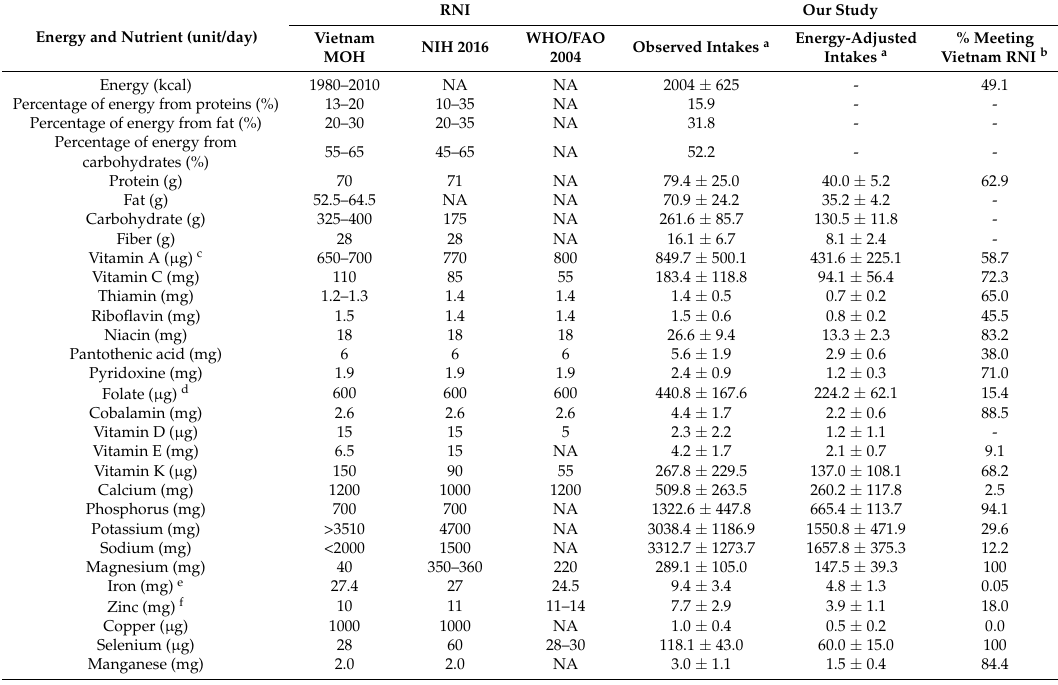
Table 4. Daily energy and nutrient intakes of pregnant women in Vietnam, 2015–2016. RNI Energy and Nutrient (unit/day)